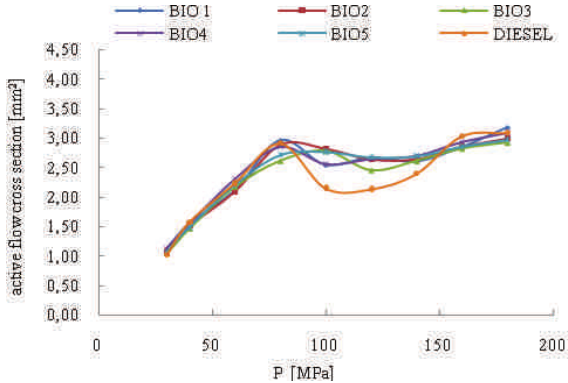
Fig. 6. Comparison of the active flow cross sections of tested biofuels at 60°C and Diesel at